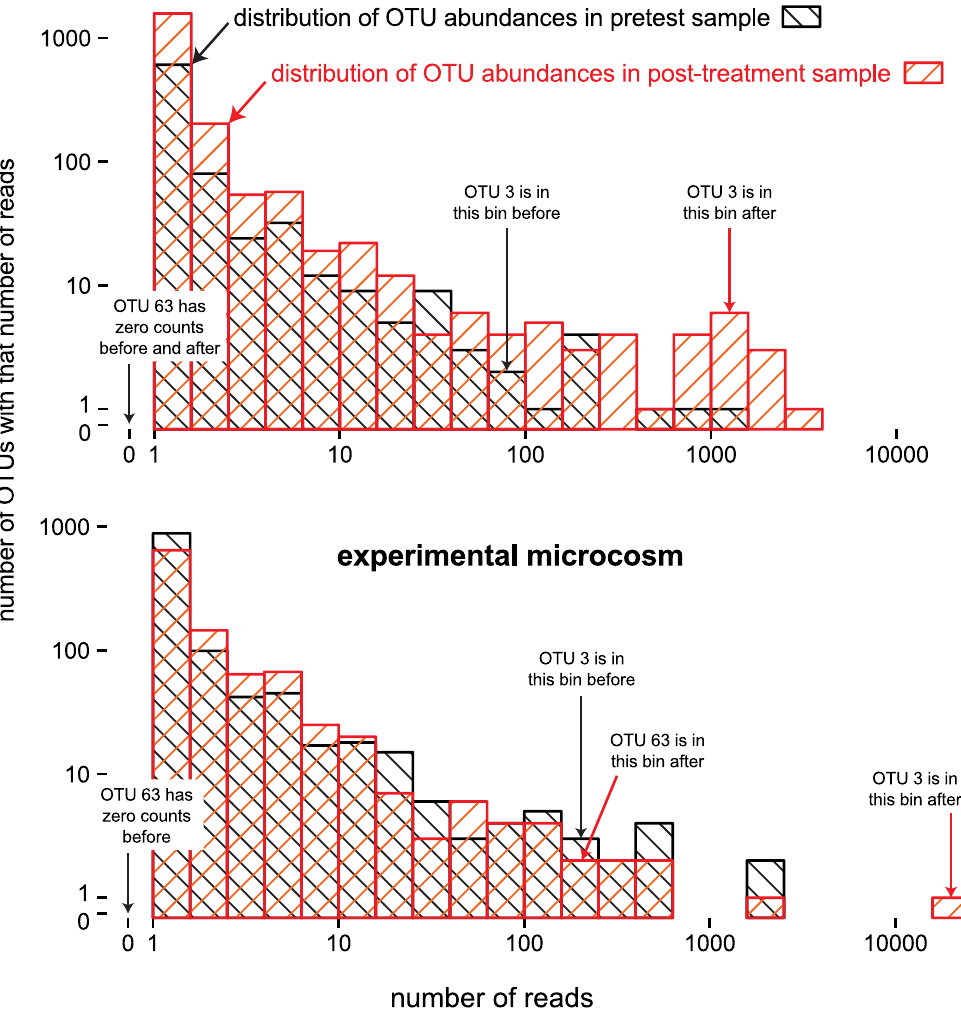
Fig 1. OTU dynamics and possible bottle effects in a paired-sample experiment. Four histograms are shown, one each for each sample in the experiment: control-before (above, black), control-after (above, red), experimental-before (below, black), experimental-after (below, red). Each histogram shows how many OTUs (logarithmic y-axes) have what number of associated reads (logarithmic x-axis). No bin is shown for OTUs with zero counts. The dynamics of two OTUs are shown: black arrows point to the abundance bin for OTUs in the “ before ” sample and red arrows point their abundance bins in the “ after ”